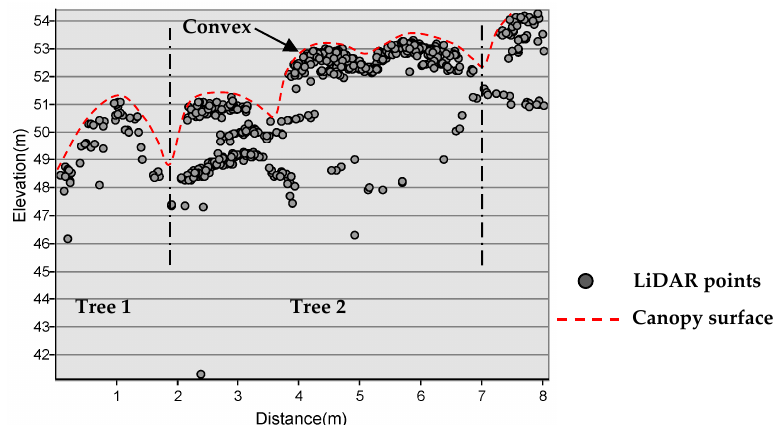
Figure 5. Point profile indicating the crown morphology of two trees delimited by dash dot lines. cell clusters extracted through statistical significance tests. As indicated in Figure 6, the local G i * values on the cells in dark blue color are lower than 2.576, i.e., the critical